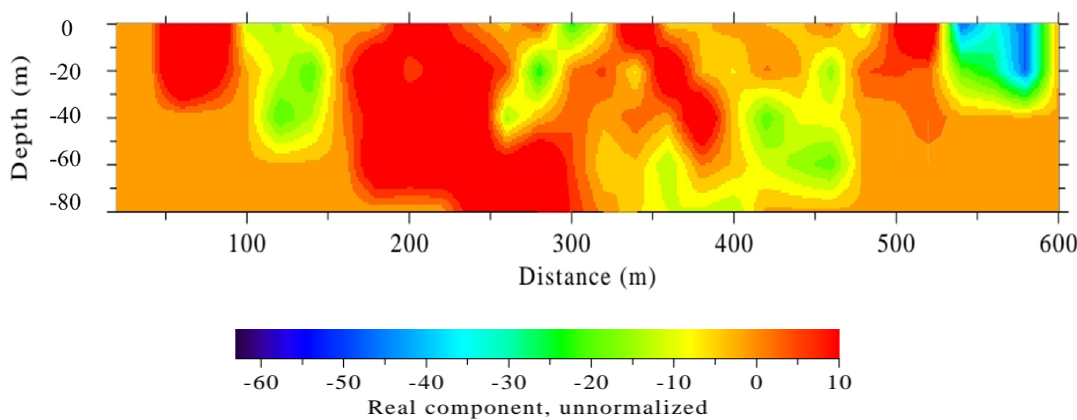
Figure 10. Karous–Hjelt current density pseudo-section showing inferred / potential conductive and resistive structures along VLFEM profile. Current density scale is arbitrary color codes with conductivity increasing from negative to positive. The high positive value constitutes the conductive sub-surface, and low negative value represents a resistive subsurface.